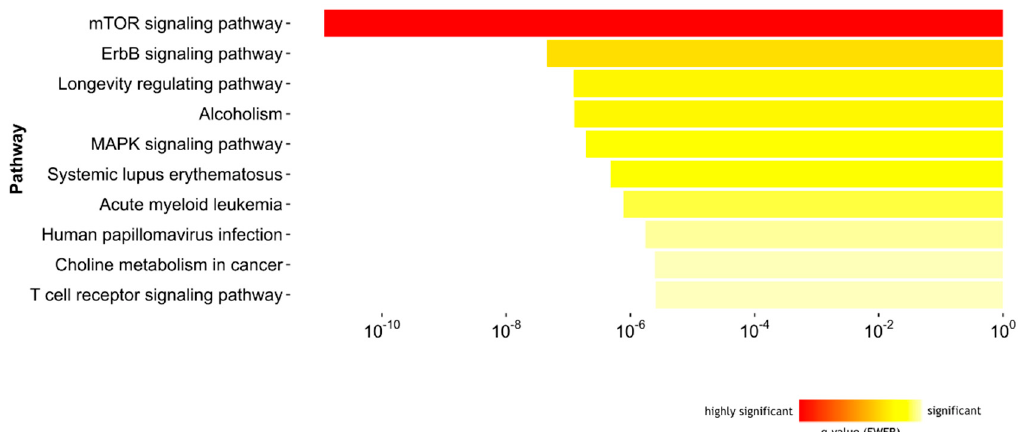
Figure 4. The relationship between DNA methylation changes with biological pathways. The top 10 enriched pathways for the genes within DMRs associated with airborne and food allergen sensitization at age 5Y in ALADDIN. Genes mapped to DMRs in maternal PBMCs associated with airborne sensitization at 5 years were enriched in pathways of mTOR signaling pathway (q = 1.3 × 10 − 11 ) and MAP kinase signaling pathway (q = 4.4 × 10 − 6 ) (Figure 5).